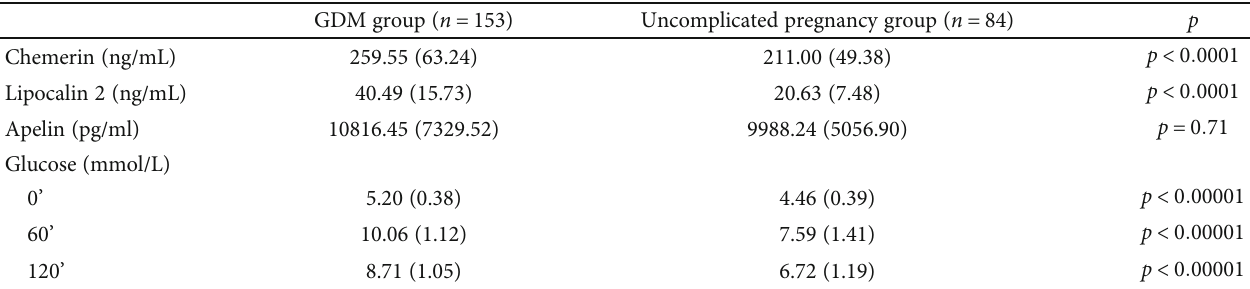
Table 2: Chemerin, lipocalin 2, apelin, and glucose concentrations in both groups (mean and standard deviation). GDM group ( n = 153